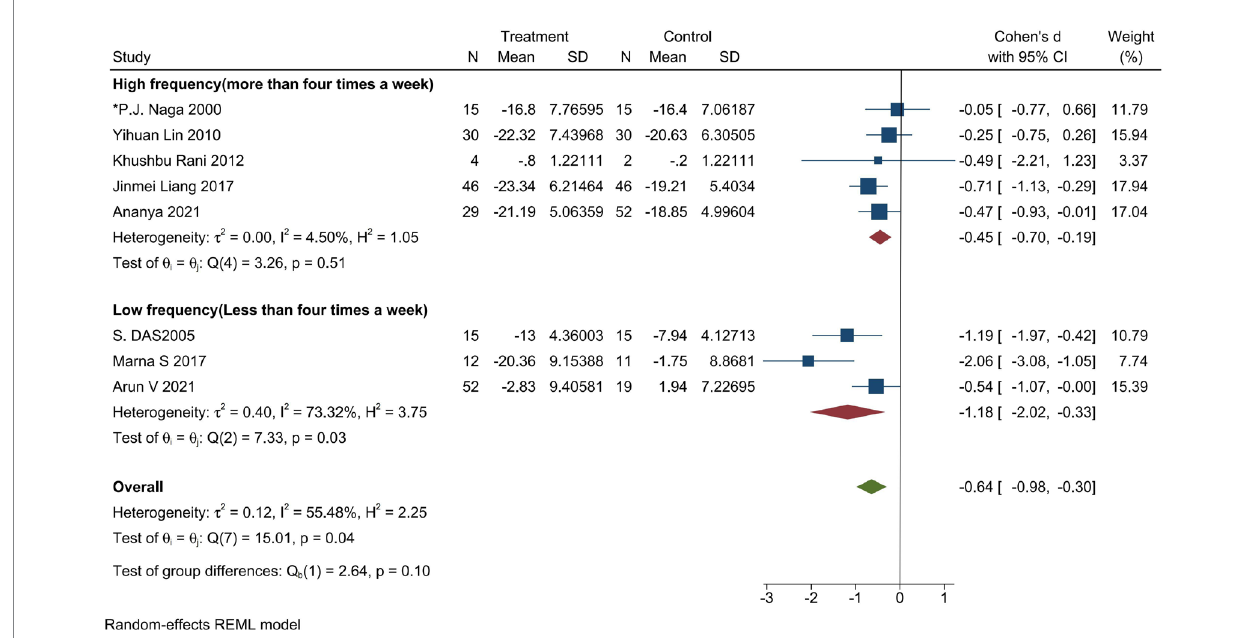
FIGURE 13 Forest plot of subgroup analysis regarding intervention